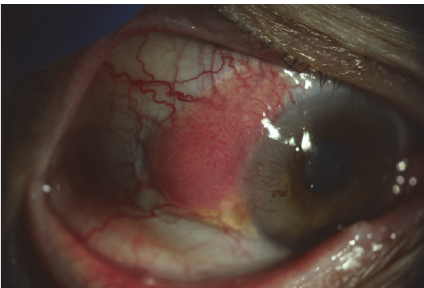
Figure 1: Slit lamp photograph of a corneal-conjunctival intraep- ithelial neoplasia with gelatinous and papilliform features as well as feeder